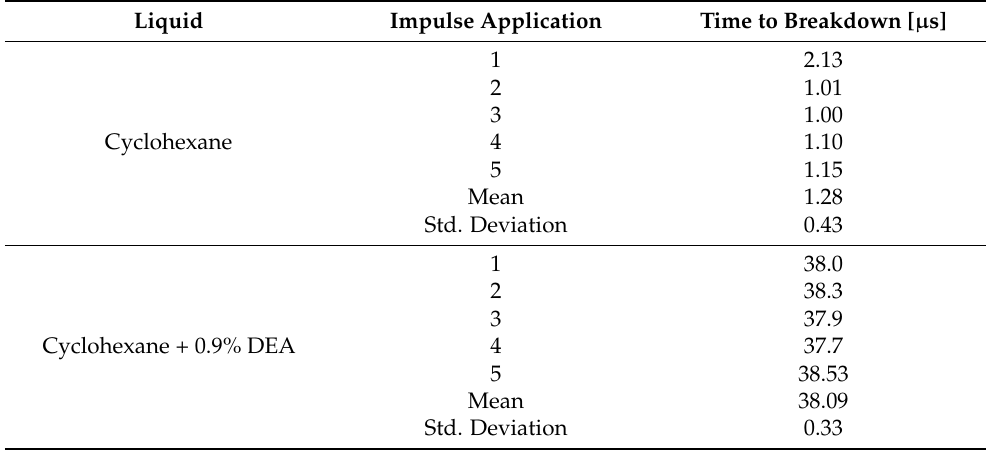
Table 2. The time to breakdown for cyclohexane with and without 0.9% DEA when tested with a positive lightning impulse (1.2/50 µ s) with a 70 mm gap (point-plane arrangement). The peak voltage magnitude for each impulse application was between 235 to 240